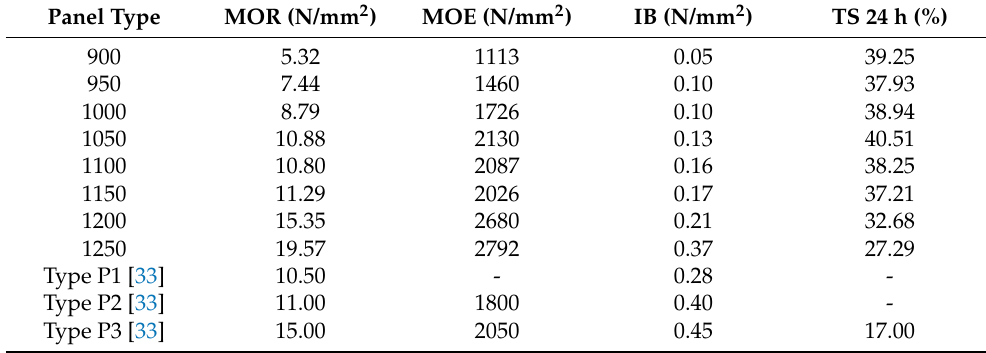
Table 4. Average properties of the experimental panels and the European standards’ requirements [33].